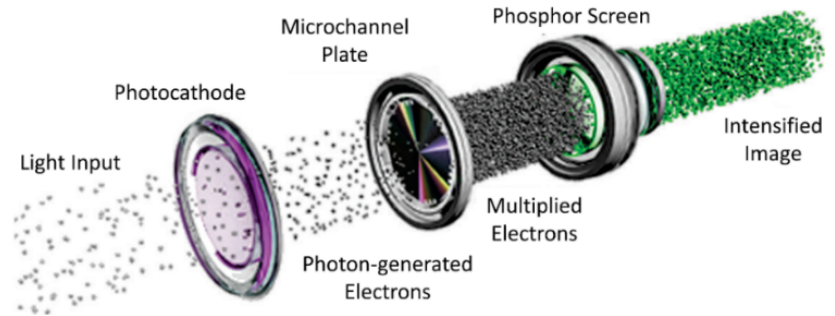
Figure 2. Schematic of the image intensifier tube.